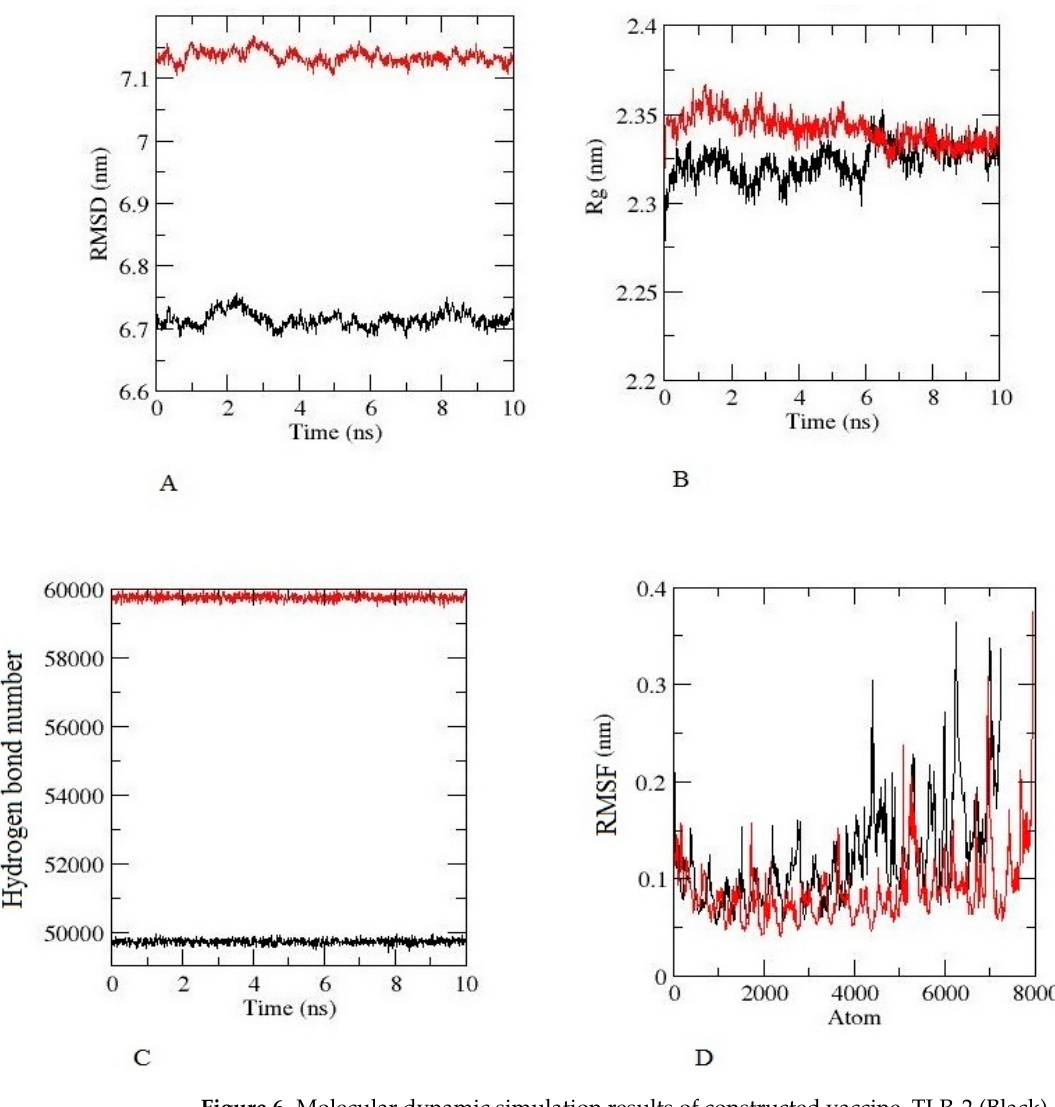
Figure 6. Molecular dynamic simulation results of constructed vaccine, TLR-2 (Black), TLR-2 (Red), for 10 ns ( A ) The RMSD plot ( B ) The Rg (radius of gyration) plot. ( C ) The hydrogen bond plot of constructed vaccine and TLRs docked complexes. ( D ) RMSF profile of docked complexes.